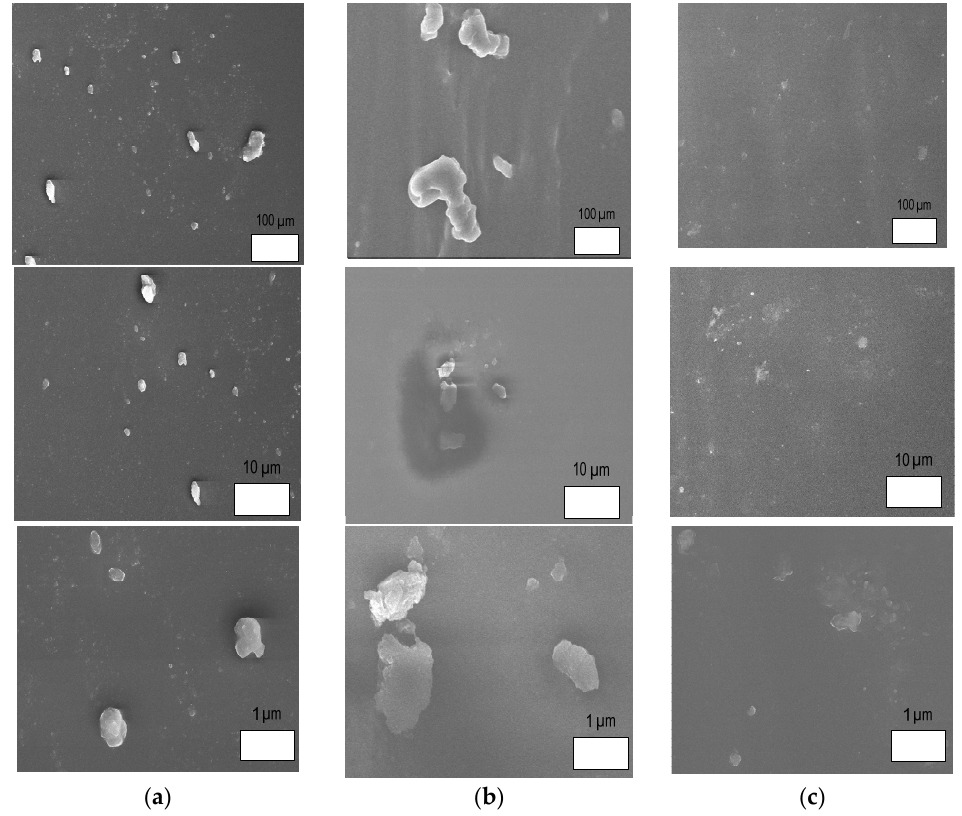
Figure 10. Field emission scanning electron microscopy (FESEM) images at 5 wt % for ( a ) DMNC; ( b ) STNC; and ( c ) PTNC .